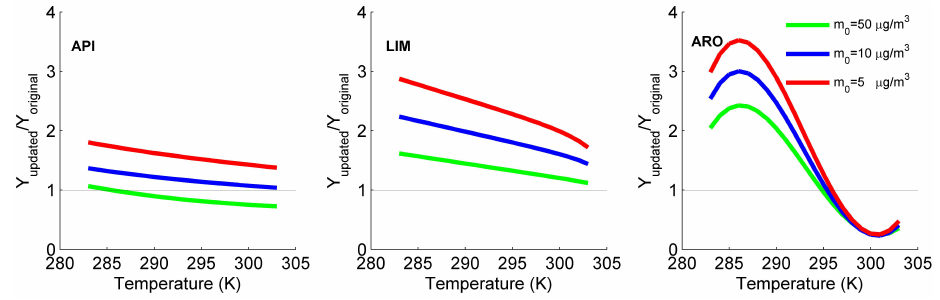
Fig. 3. Temperature dependence of the ratio between the updated SOA yields ( Y updated ) calculated with temperature parameterized α and K and the original SOA yields ( Y original ) used in SORGAM for mechanistic categories API, LIM and ARO for 3 different mass